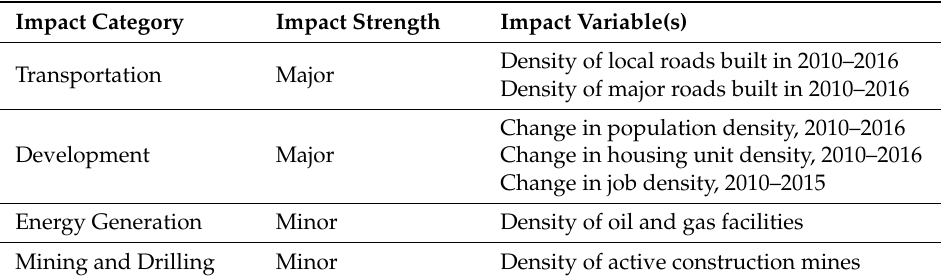
Table 3. Characterizing current demand for stream mitigation based on